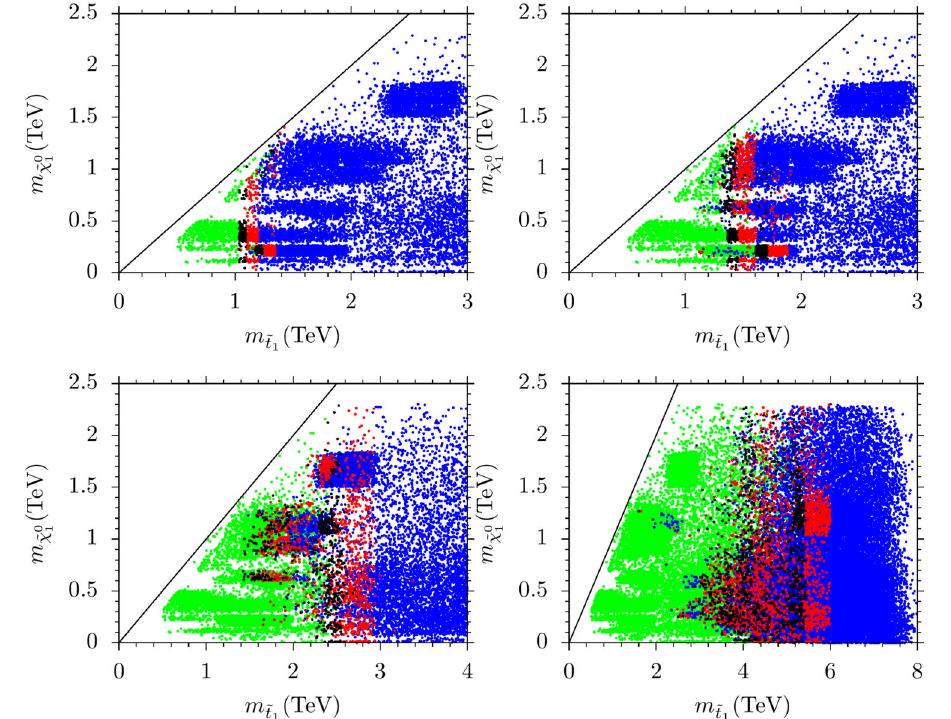
− m ˜ Fig. 10 Plots in the m ˜ χ 0 t 1 planes showing the combined signal 1 strength of the three class of the signal processes in the same color cod- ing as Fig. 5 for the experiments of 14 TeV (top left), 27 TeV (top right),